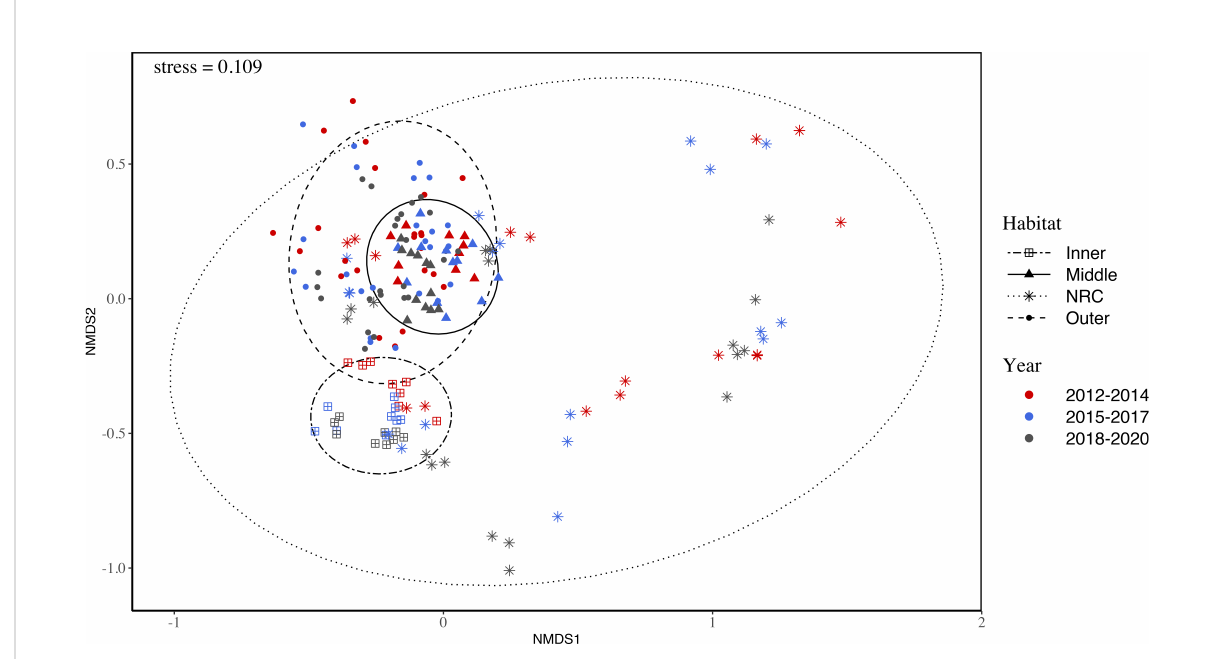
FIGURE 4 Non-metric multidimensional ordination plot (nMDS) based on Bray-Curtis dissimilarity of survey sites representing the overall abundance of stony coral species by habitat and year